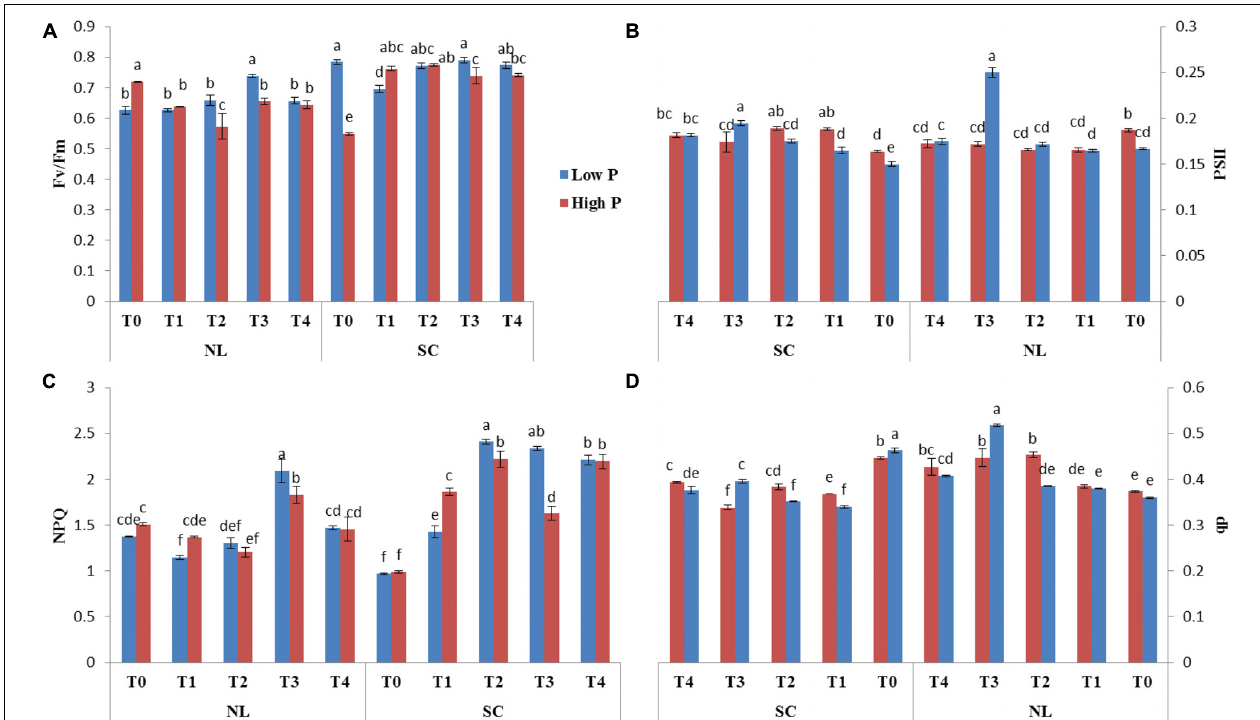
FIGURE 3 | Effect of Ti on (A) Fv/ Fm, (B) PSII, (C) NPQ, and (D) qp of soybean leaf under NL and SC combined with LP and HP conditions. The bar plots with different lettering show the significant difference among cultivars at probability < 0.05. The error bars are the ± SD values with n = 3.